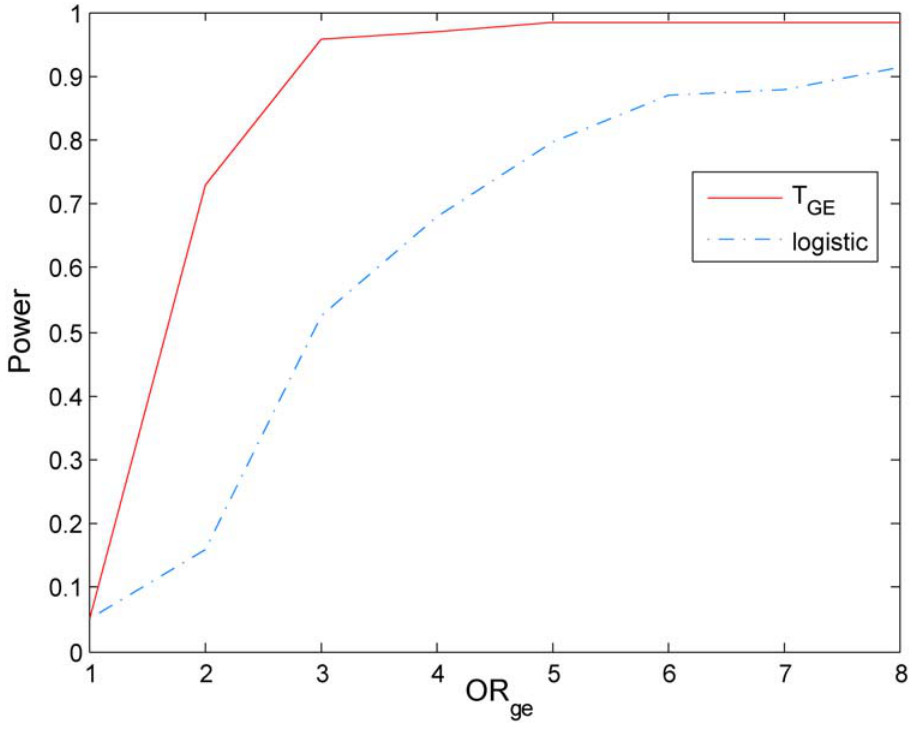
Figure 5. Power of the statistic T I and logistic regression analysis for 300 cases and controls respectively.